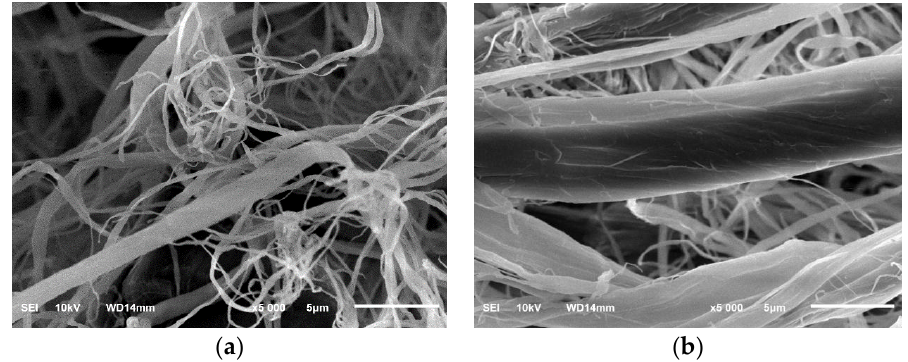
Figure 3. SEM micrographs of aramid fiber: ( a ) untreated aramid fiber and ( b ) aramid fiber after cleaning with acetone.